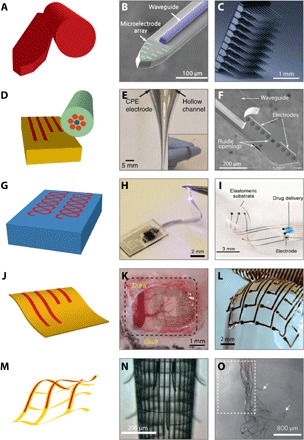
Evolution of form factors for neural interfacing.(A to C) Rigid, Si-based probes are commercially available and considered state of the art. (B) Si-based Michigan probe, modified with a patterned waveguide. Reproduced with permission from Son et al. (224). (C) Utah array (Blackrock Microsystems LLC). (D to F) Thick fiber and polymer-based probes. (E) Thermal drawing of macroscale preforms allows for multifunctional fibers that can bend and flex. A single fiber can contain electrical recording sites (CPE or Sn), guide light, or pass fluid. Reproduced with permission from Canales et al. (55). (F) Polymer probes (based on PI and SU-8) can also be assembled to support optical and fluidic stimulation and electrical interfacing. Reproduced with permission from Rubehn et al. (56). (G to I) Elastomeric probes are generally thick but are compliant and stretchable. (H) PDMS probe with off-the-shelf components and serpentine metallic structures. Reproduced with permission from Park et al. (59). (I) EDura: PDMS-based probe with electrodes and a microfluidic. Reproduced with permission from Minev et al. (58). (J to L) Ultrathin arrays and probes. (K) Neurogrid array: PEDOT:PSS-coated Au electrode sites on 4-μm PaC. Reproduced with permission from Khodagholy et al. (67). (L) SU-8 and Au array on silk fibroin that can be dissolved away to leave a mesh. Reproduced with permission from Kim et al. (68). (M to O) Freestanding mesh probes. (N) Stressed struts allow for global scrolling to form a probe-like geometry or (O) meshes that can be injected through a syringe. Reproduced with permission from Liu et al. (74) and Xie et al. (75). The colors used in the schematics on the left correspond roughly to the Young’s modulus scale in Fig. 2A.